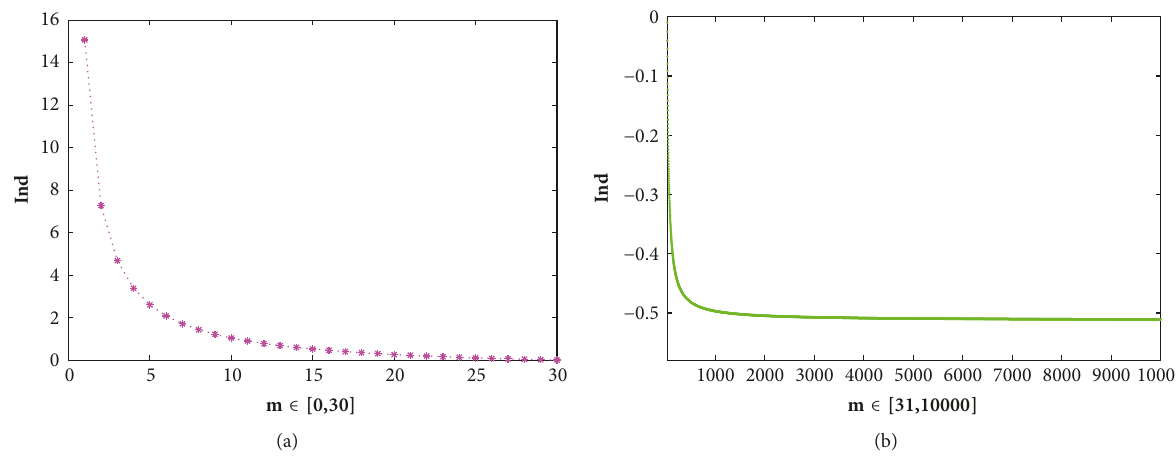
Figure 2: Ind as a function of parameter m ( 𝜃 = 0 , 𝜏 = 1 , Δ𝑥 = 𝜋/10 , 𝑟 1 = 1.0 , 𝑟 2 = 0.5 , 𝑟 3 = −1.0 , and 𝑟 4 = −0.5 ) . (a) 𝑚 ∈ [1,30] . (b) 𝑚 ∈ [31,1000]